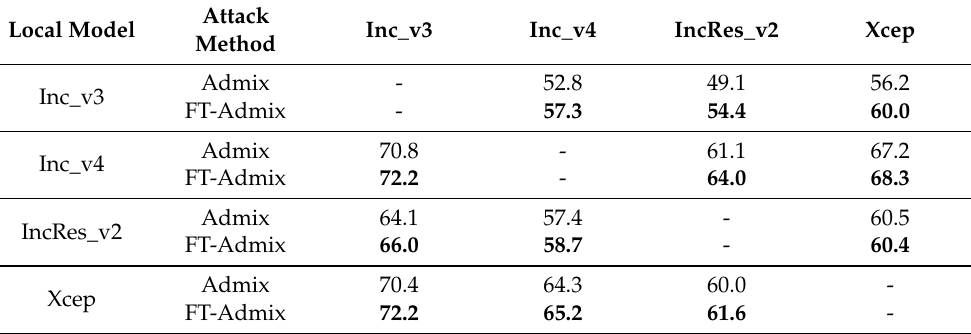
Table 5. The black-box ASRs of Admix and FT-Admix on ImageNet. The first column is the local model, and the first row is the target model. The values in the table are the ASRs (%) on the target models using the adversarial examples generated with the local models. The higher ASRs are shown in bold.